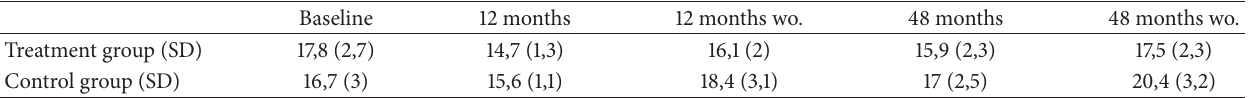
Table 1: Mean IOP values (mmHg) by visit. Baseline 12 months 12 months wo. 48 months 48 months wo.